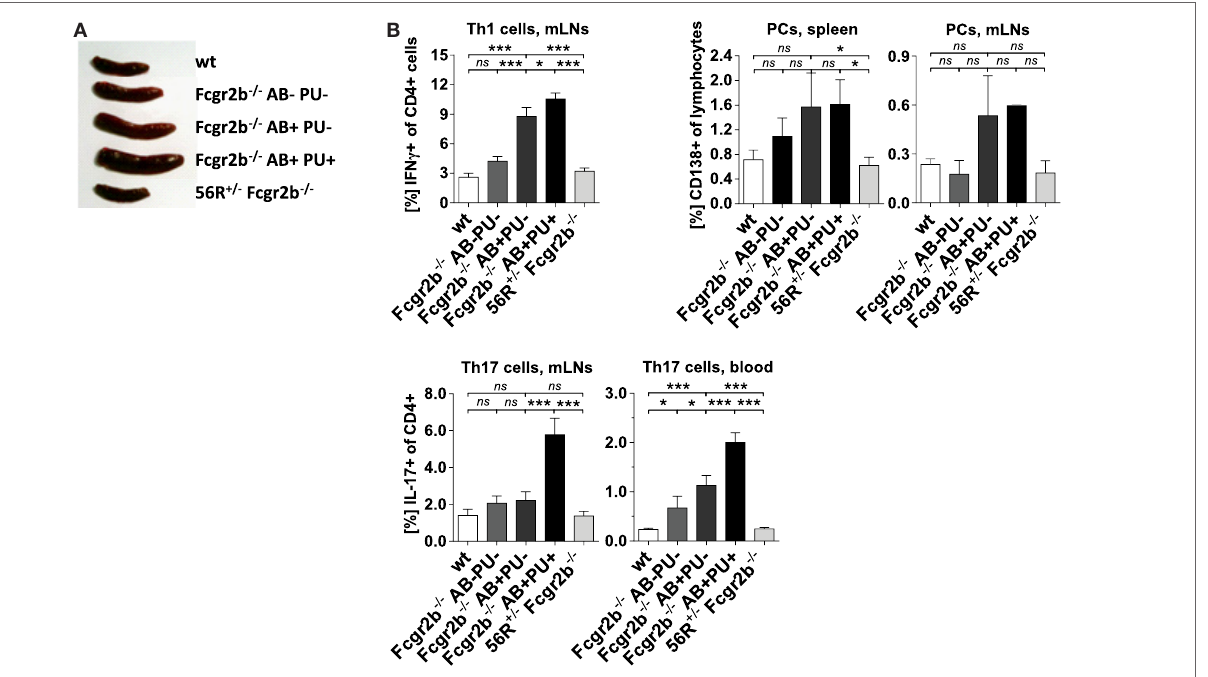
FigUre 2 | Absence of splenomegaly and no accumulation of Th1, Th17 and plasma cells (PCs) in 56R + / − Fcgr2b − / − mice. (a) Spleen sizes of 5–7-month-old wt mice, Fcgr2b − / − mice in the following disease states: IgG autoAb (AB)-negative and proteinuria (PU)-negative (AB − PU − ), AB + PU − and AB + PU + , and 56R + / − Fcgr2b − / − mice. The presented organ sizes are representative of a minimum of five mice per group. (B) The frequency of mesenteric lymph node (mLN) CD4 + IFN γ + Th1 cells, splenic and mLN CD138 + PCs and mLN and blood CD4 + IL-17 + Th17 cells of 5–7-month-old wt mice (Th1 cells, mLNs, n = 8/PCs, spleen, n = 3/PCs, mLNs, n = 3/Th17 cells, mLNs, n = 8/Th17 cells, blood, n = 15), Fcgr2b − / − mice [AB − PU − ( n = 12/3/3/12/10), AB + PU − ( n = 12/3/3/21/17) and AB + PU + ( n = 11/3/3/13/7)] and 56R + / − Fcgr2b − / − mice ( n = 12/12/3/12/26), as measured by flow cytometry. The bars indicate the mean